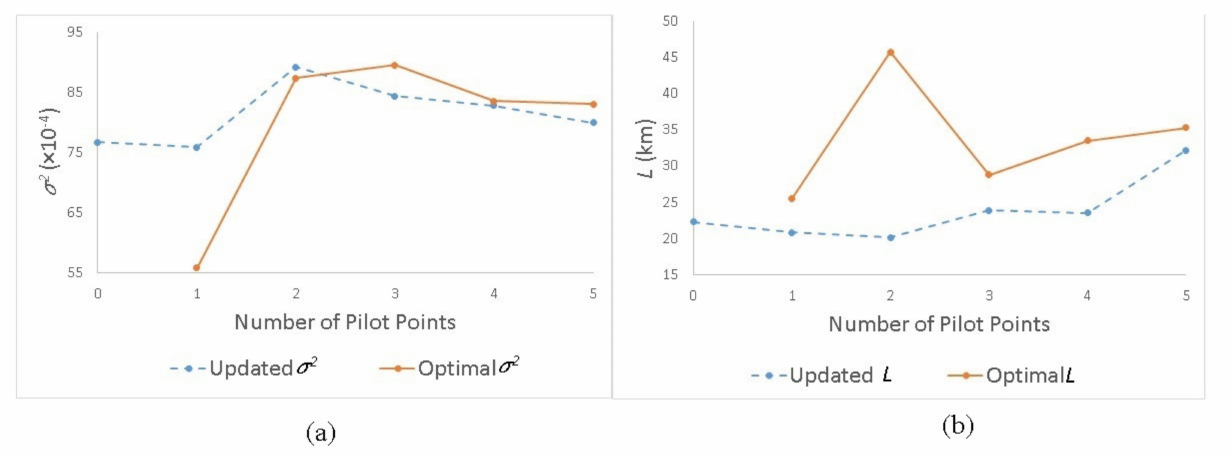
Figure 3. Convergence between the two components of θ U and θ ∗ : ( a ) σ 2 and ( b ) L